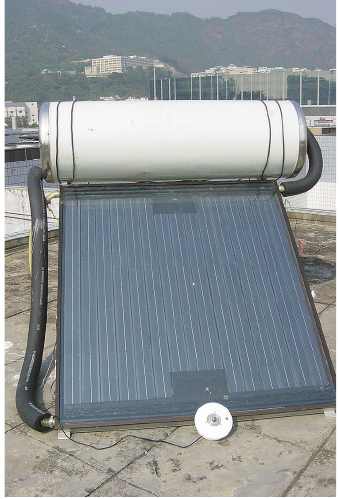
Figure 2: Front view of free-stand PV/T collector